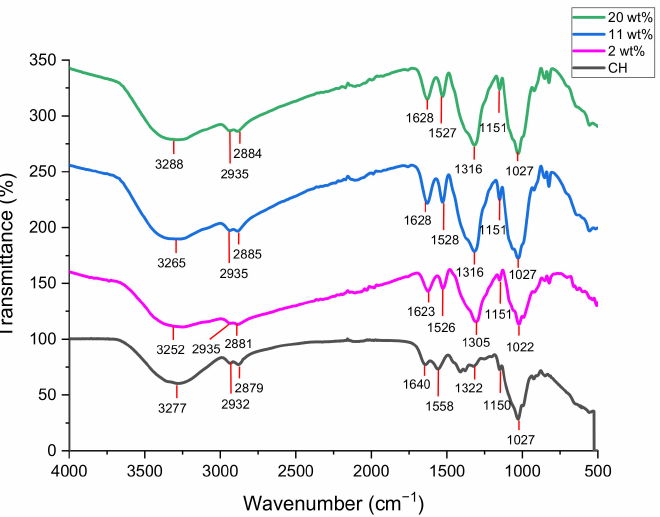
Figure 2. Infrared spectra for pure CH and CH/Na/CuSe polymer matrix with 2 wt%, 11 wt%, and 20 wt% of CuSe filler.